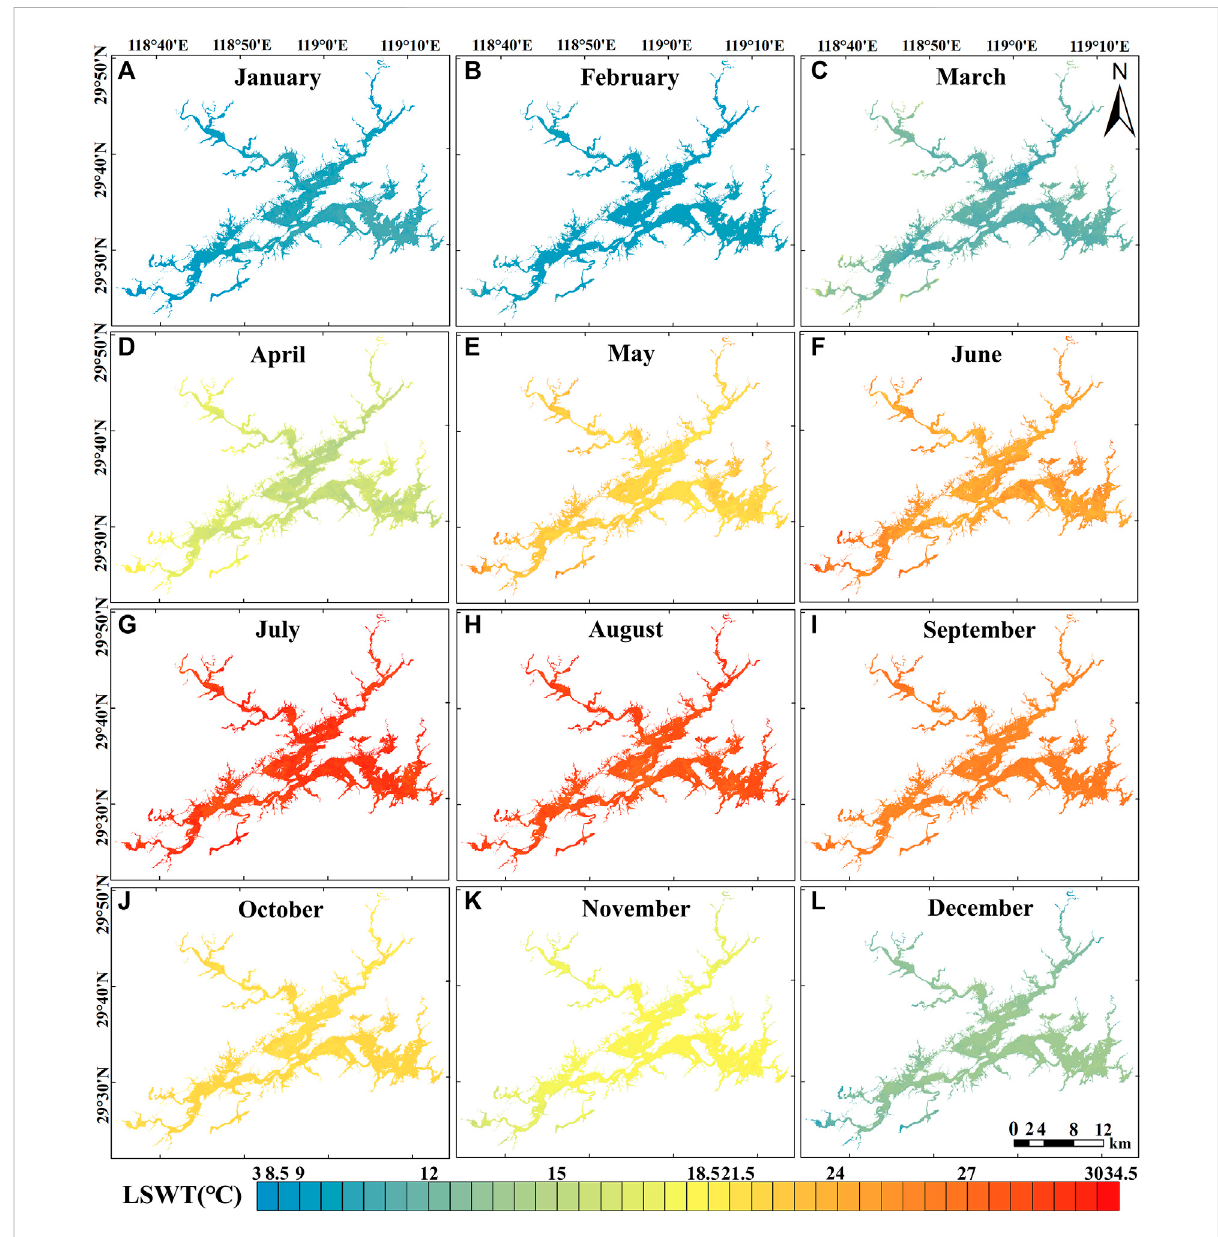
FIGURE 5 Monthly averaged LSWT in Lake Qiandaohu from 1986 to 2021. (A – L) represent January to December,